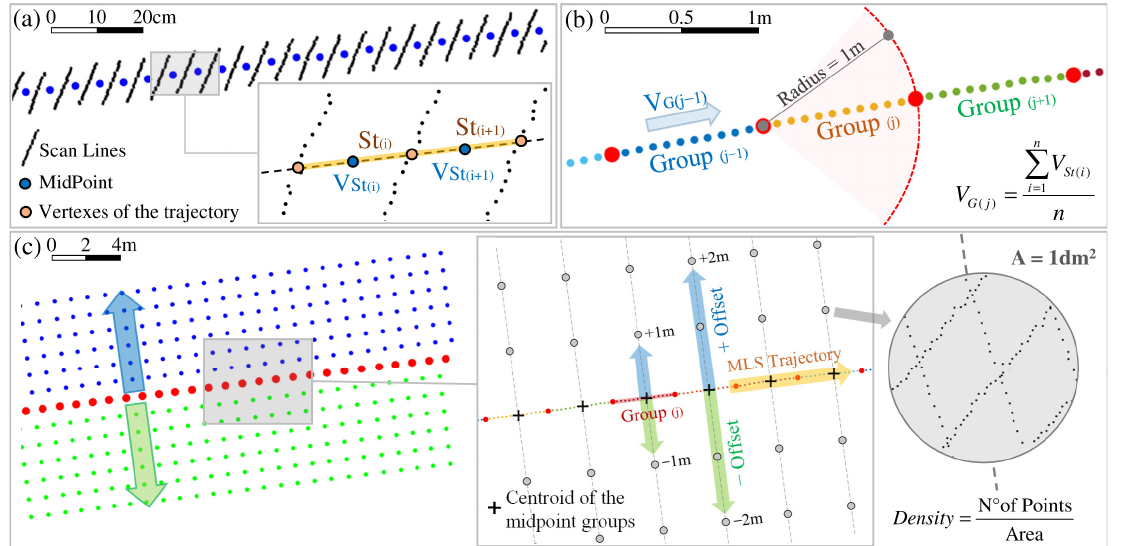
Figure 4. Computing of density. ( a ) Midpoints of the segments of length St, the velocity V St is associated with each point; ( b ) Grouping the midpoints in groups 1 m long and computation of the mean velocity V G associated with each group; ( c ) in the left panel, an excerpt of the grid formed by the offset points is shown, and in the right panel a zoomed-in view with an additional zoom to display the circumference of 1 dm 2 for density computation is shown.